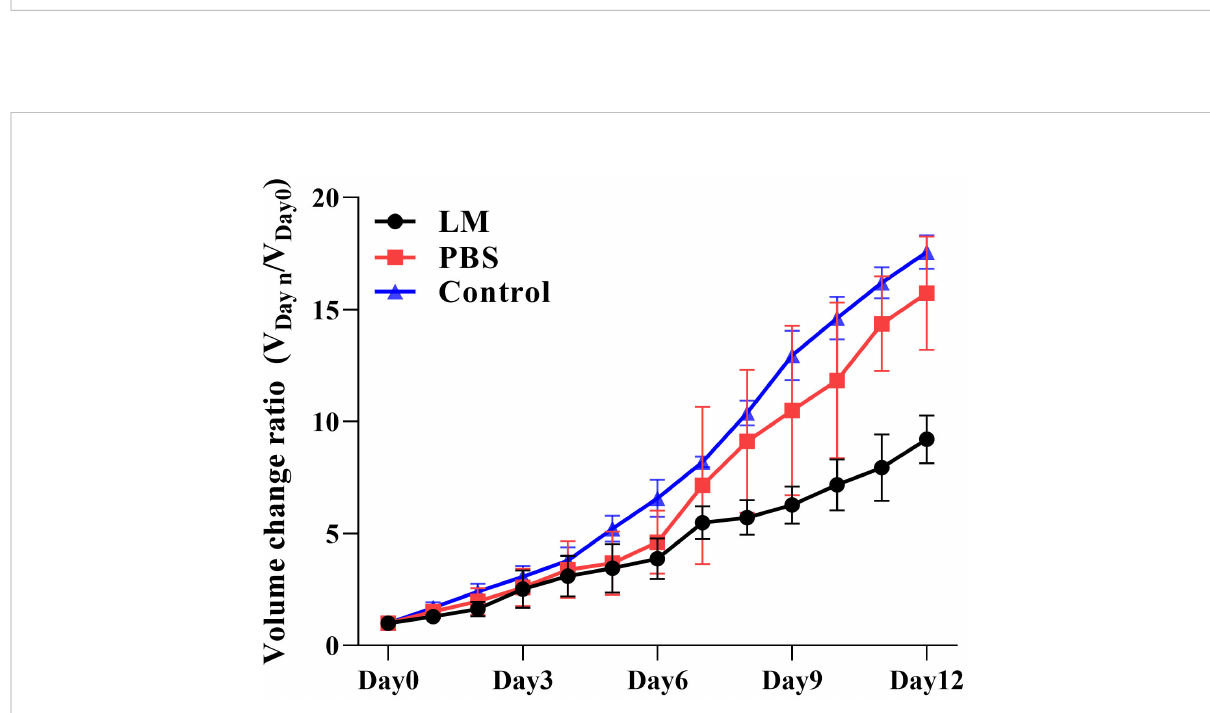
FIGURE 3 Trend plot of tumor volume ratio with different growth days in LM group, PBS group and control group. V Dayn /V Day0 represents the change rate of tumor volume on day n relative to that on day 0; V Day0 represents the tumor volume on day 0. Eight mice were selected in each group to measure the tumor size every day. LM, liquid metal; PBS, phosphate buffer